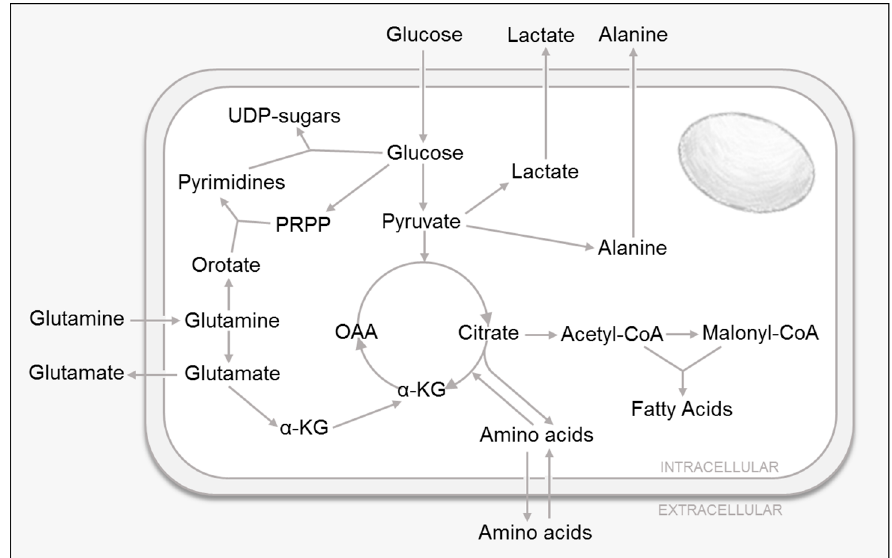
Figure 1. Central Carbon Metabolism.